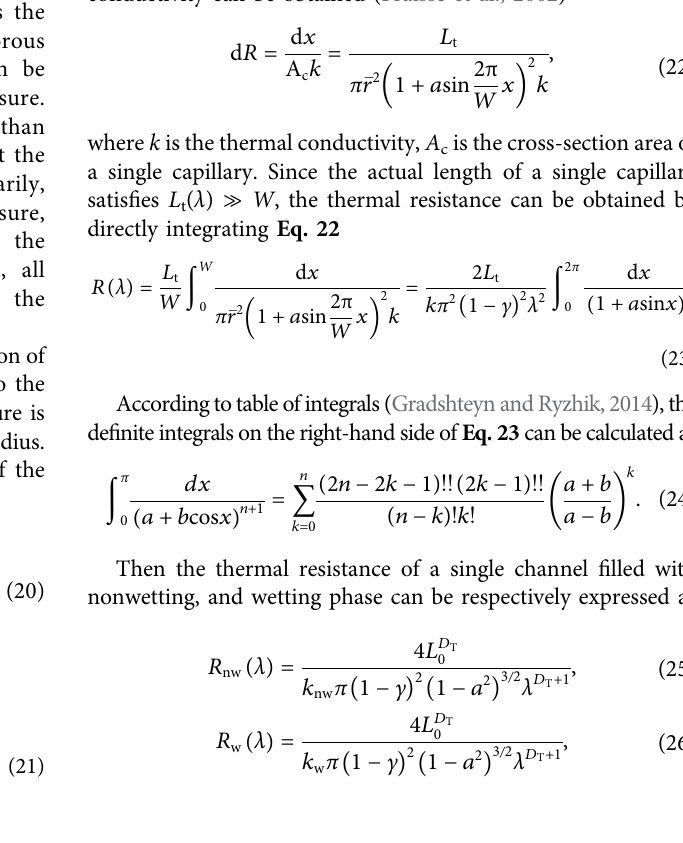
Frontiers in Earth Science |